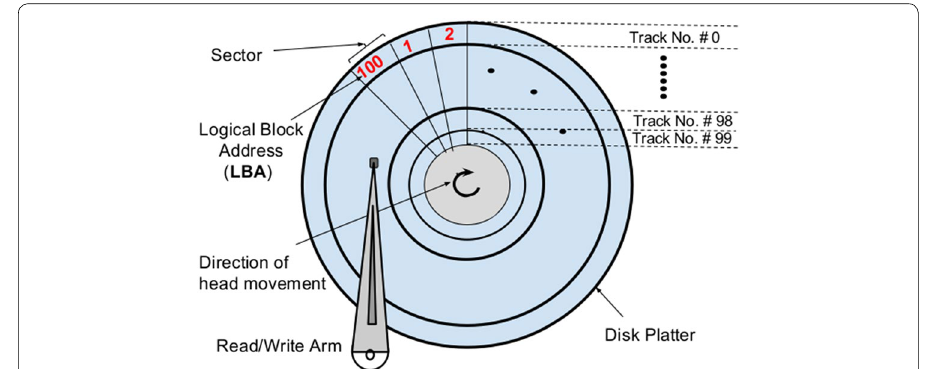
Fig. 3 Geometry of the HDD with 1 platter, 100 sectors/track and 100 tracks/platter